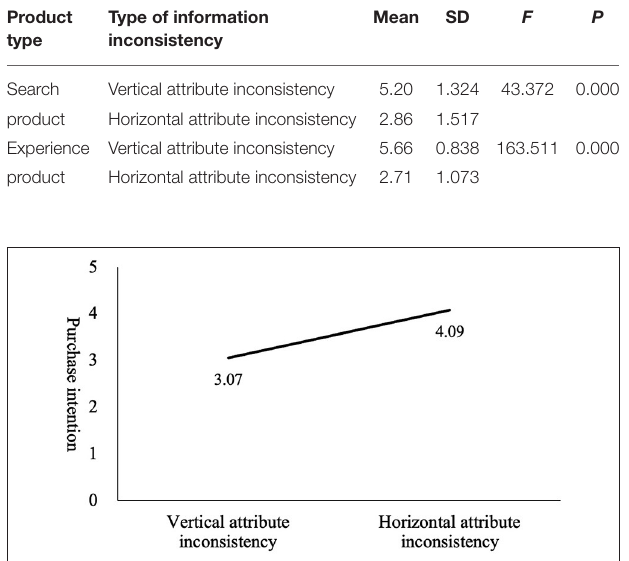
FIGURE 2 | The effect of the type of information inconsistency on purchase